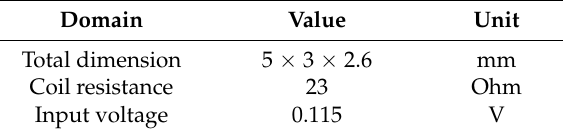
Table 3. Model detail.